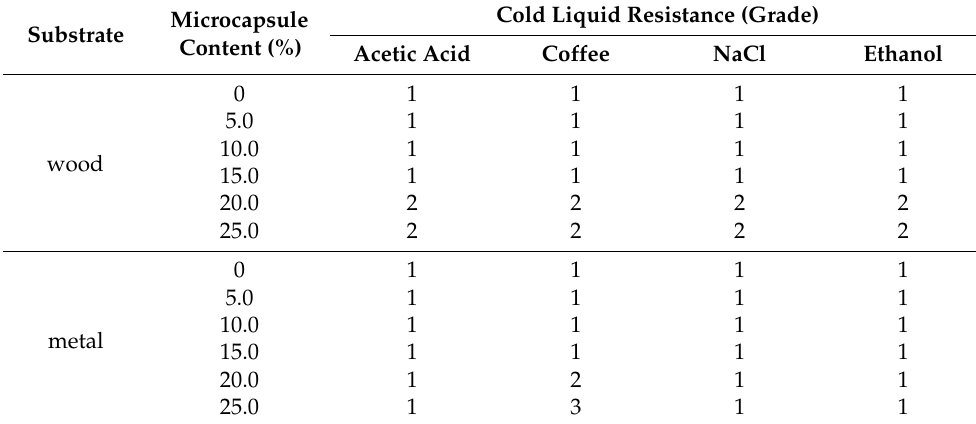
Table 12. Cold liquid resistance grade of the coatings with different loadings of